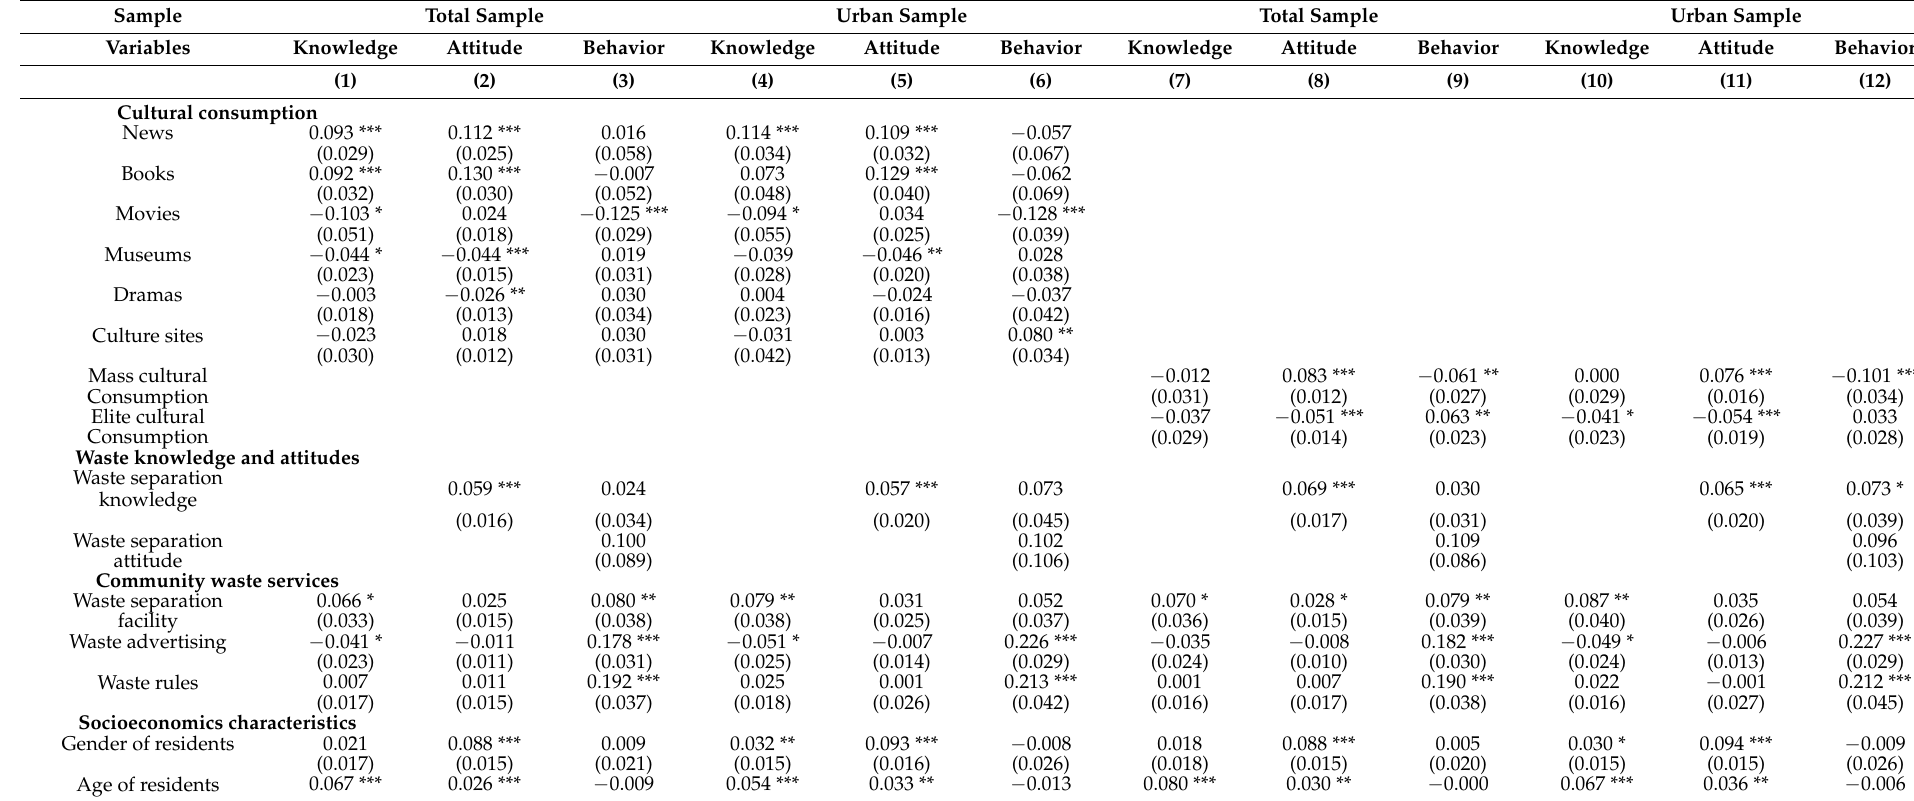
Table 3. Impact of cultural consumption on waste separation knowledge, attitudes, and